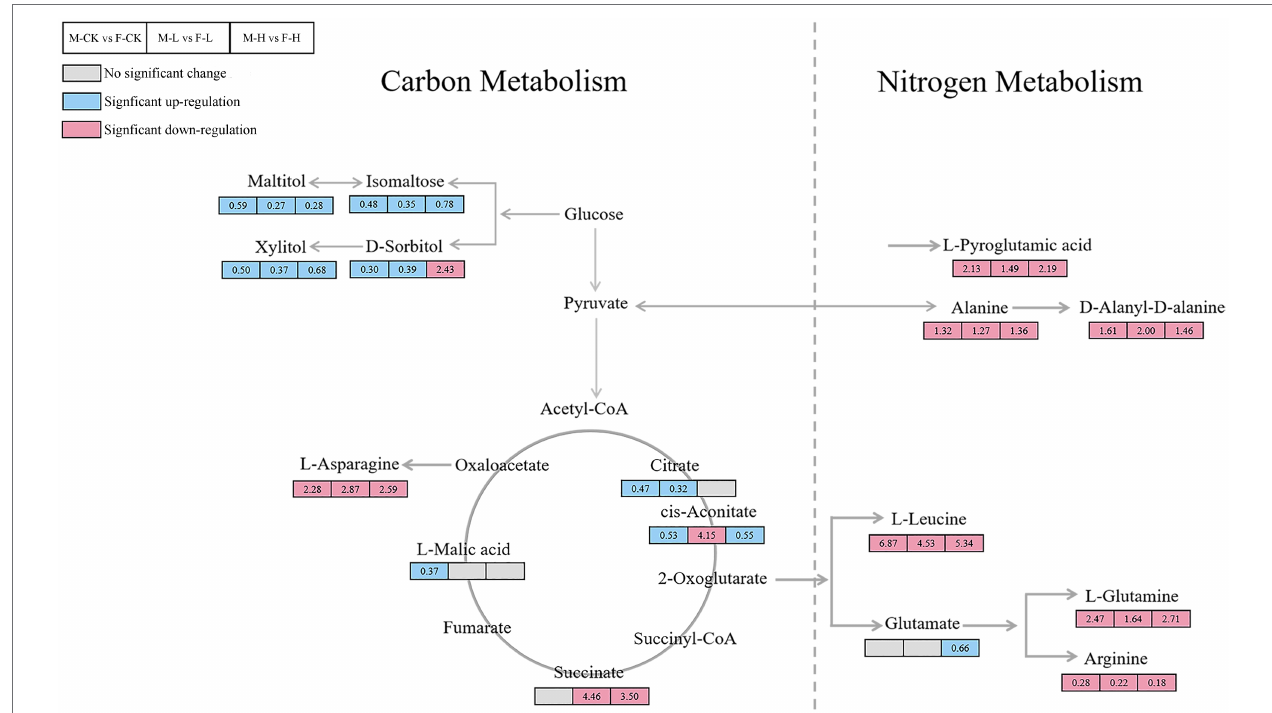
FIGURE 6 | Summary of the significantly changed metabolites under control group, low, and high UV-B radiation. The values in the box represent the fold change of the metabolites; M-CK means: the control group of males; M-L means: males under low UV-B radiation conditions; M-H means: males under high UV-B radiation conditions; F-CK means: the control group of females; F-L means: females under low UV-B radiation conditions; and F-H means: females under high UV-B radiation conditions. Gray rectangle represents metabolite content has insignificant differences between male and female Sargassum thunbergii . Red rectangle represents metabolite content in males significantly higher than females. Blue rectangle represents metabolite content in females significantly higher than